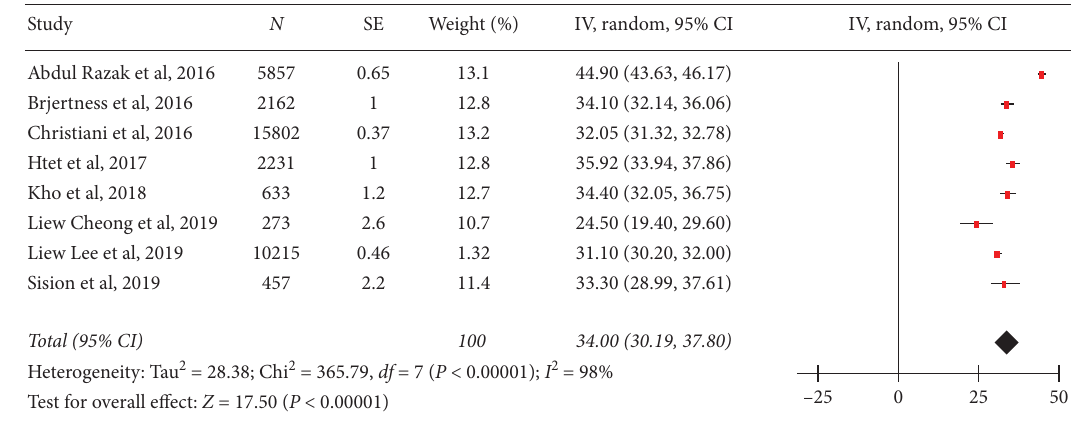
Figure 2: Forest plot representation of the overall